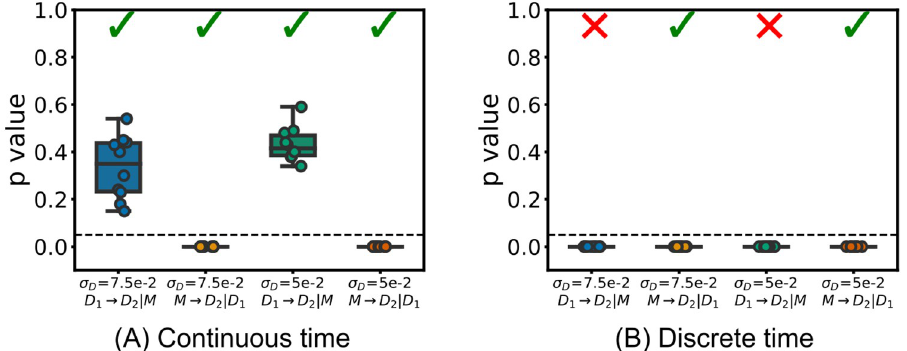
Fig 7. The p -values obtained when using continuous and discrete-time estimators to infer non-zero information flow in the noisy copy process. The estimators are applied to both _ T (expected to have non-zero flow and therefore be indicated as statistically significant). Only the results from the continuous-time estimator match these expectations. Ticks represent the particular combination of estimator and surrogate generation scheme making the correct inference in the majority of cases when a cutoff value of p = 0.05 is used. The dotted line shows p =